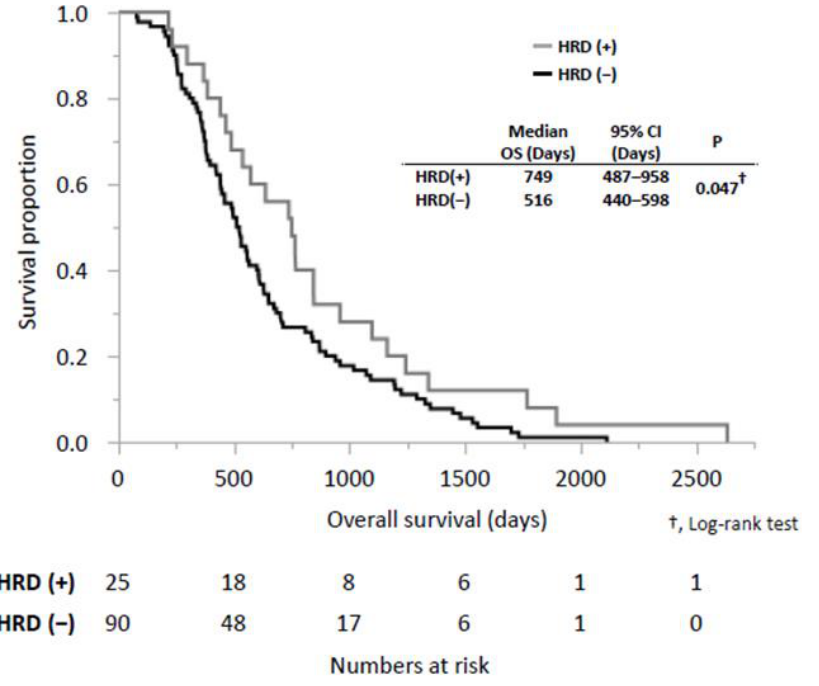
Figure 2. Comparison of overall survival (OS) between the patients who had homologous recom- bination deficiency (HRD)-related genetic mutations (HRD (+)) and those who did not (HRD ( − )). †, Log-rank test; OS, overall survival; HRD, homologous recombination deficiency; CI, confidence in- terval. Table 4. Univariate and multivariate analyses of factors associated with overall survival (OS). Univariate Analysis Multivariate Analysis HR 95% CI p -Value HR 95% CI p -Value